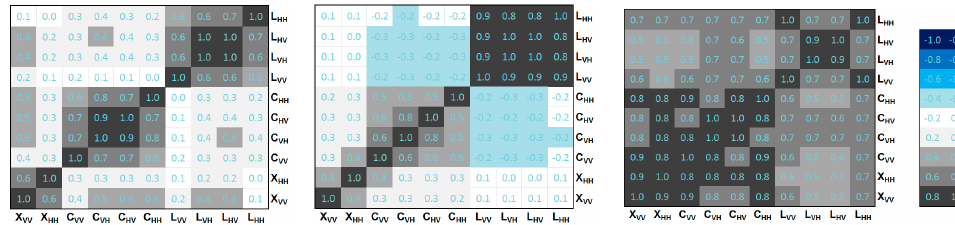
Figure 9. r s domain for plot 450 three selected times: 13 June (left panel); 21 June (center panel) and 26 July (right panel). The dichromatic color ramp describes very strong negative to very strong positive correlations (from blue to grey). Values of r s rounded to first decimal place are also reported. On 13 June, the higher correlations among channels of the same frequency are observable. More specifically, moderate to very strong correlations occur among X, C and L frequency channels.